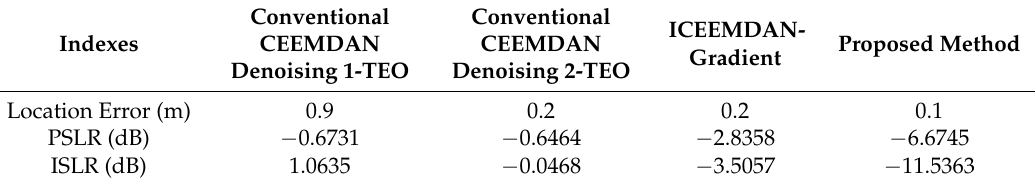
method. Table 2. The evaluation indexes of the detection results based on different